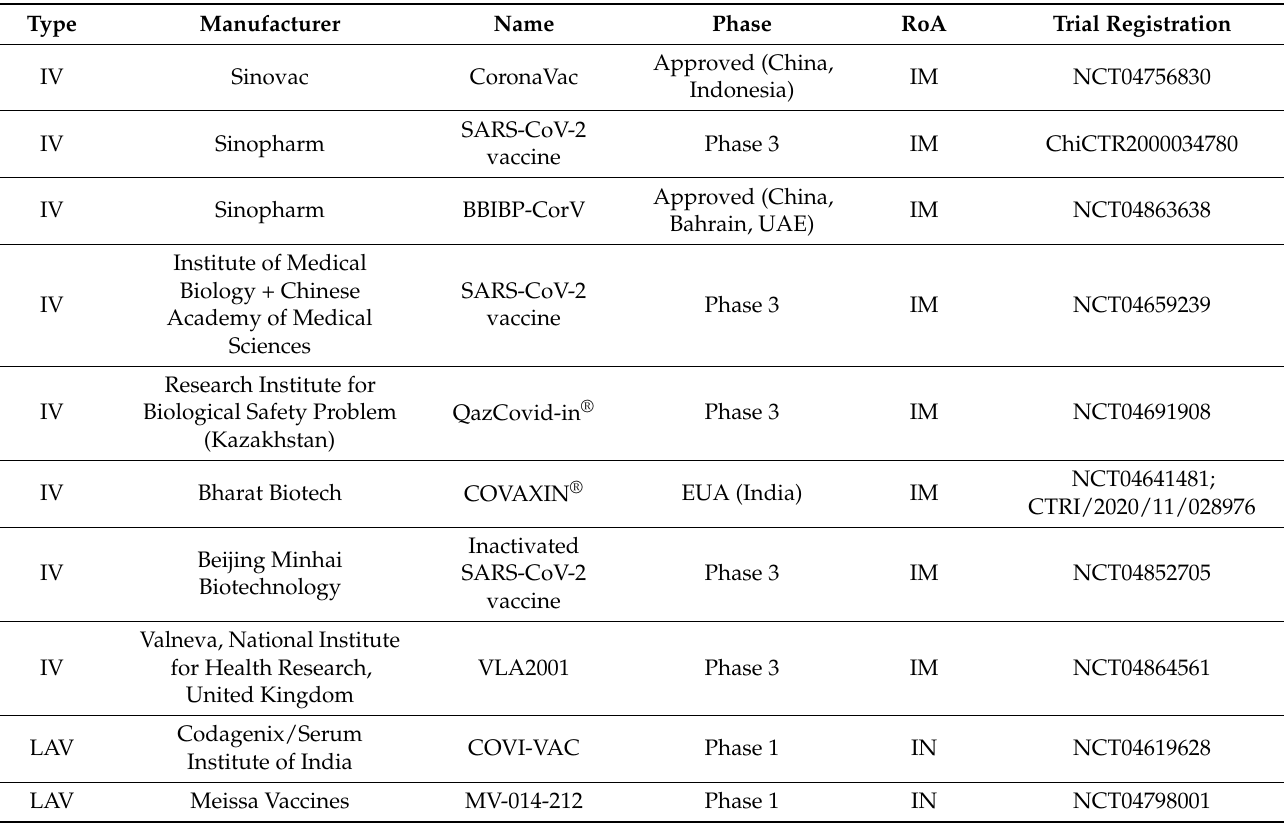
Table 4. Promising COVID-19 inactivated vaccines (IV) and live-attenuated vaccine (LAV) candidates in clinical development.